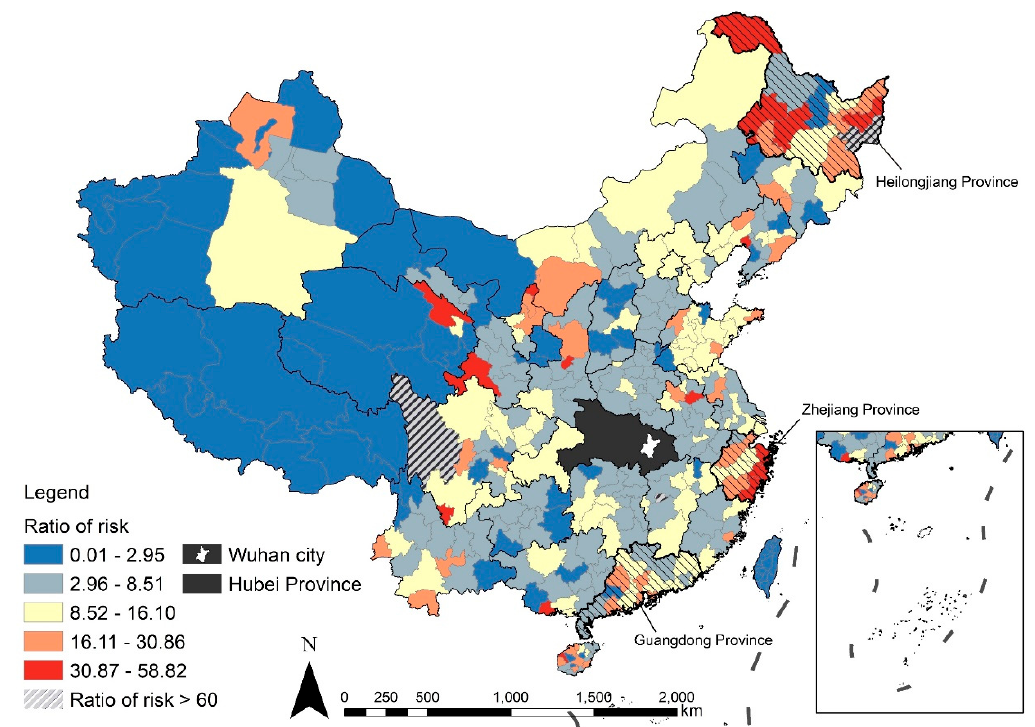
Figure 3. Ratio of the risk of imported 2019 novel coronavirus (COVID-19) transmission for each city (by natural Jenks).